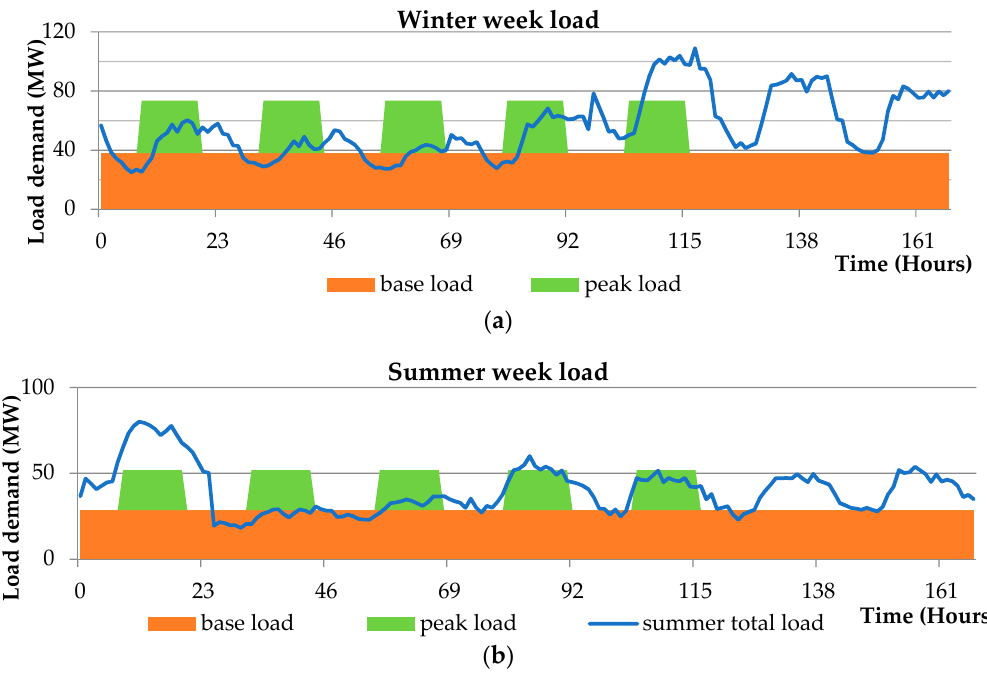
Figure 8. Adapted weekly load profiles of base and peak loads for the Week Futures market: ( a ) Winter Weekly; ( b ) Summer Weekly.